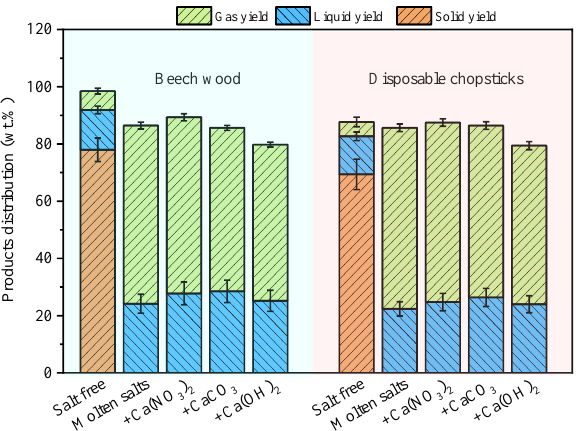
Figure 1. Products distribution in salt free/molten salts pyrolysis of the two